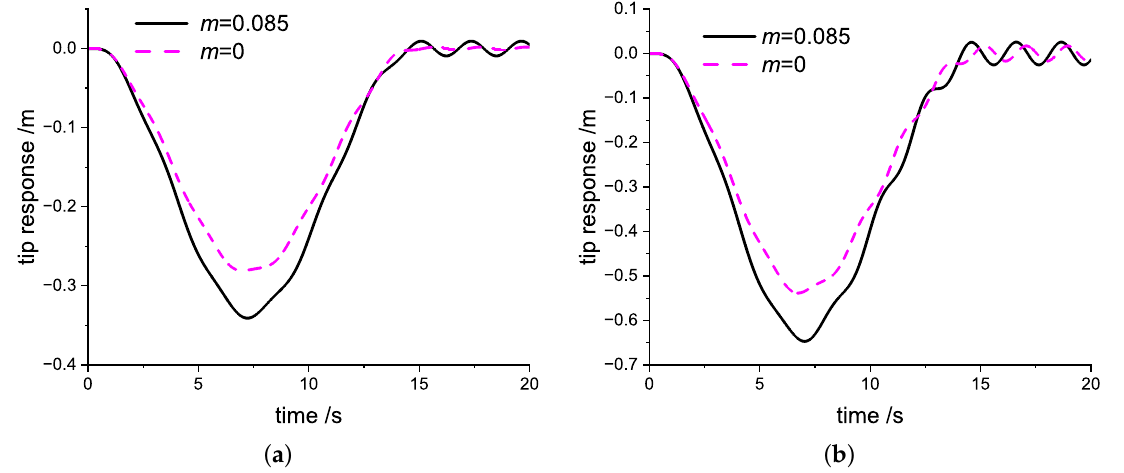
Figure 5. The response of beam’s free end for different free end mass m : ( a ) Ω 0 = 2 rad/s; ( b ) Ω 0 = 4